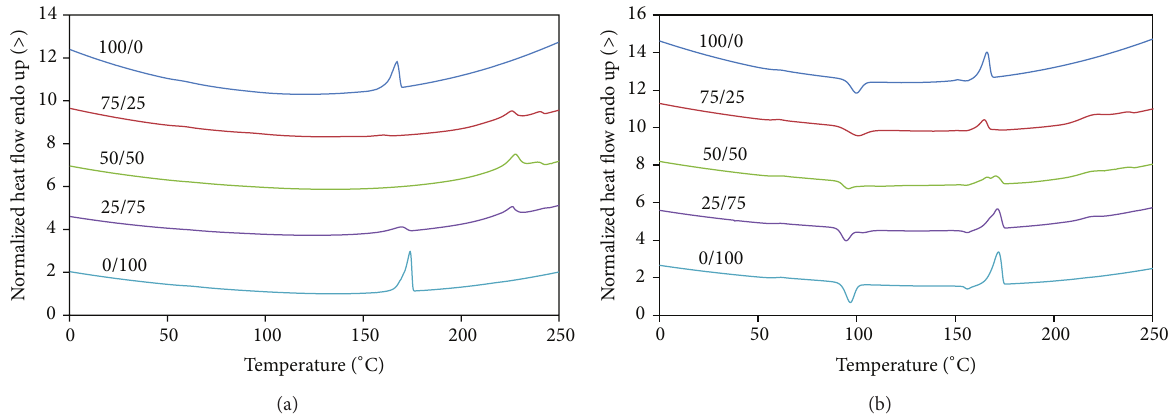
Figure 1: DSC thermograms of (a) 1st and (b) 2nd heating scans of 6PLL, 1PDL15K, and polylactide stereocomplexes prepared with different 6PLL/1PDL15K blend ratios.